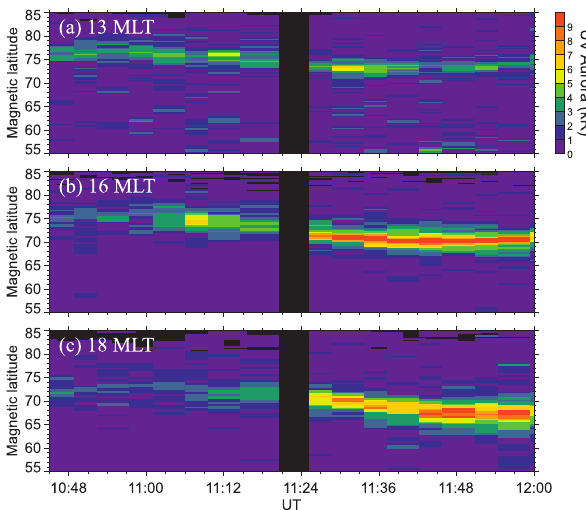
Fig. 7. The latitudinal variation of the UV auroral emissions mea- sured (a) 13 MLT, (b) 16 MLT, and (c) 18 MLT by the VIS Earth Camera between 10:45 UT and 12:00